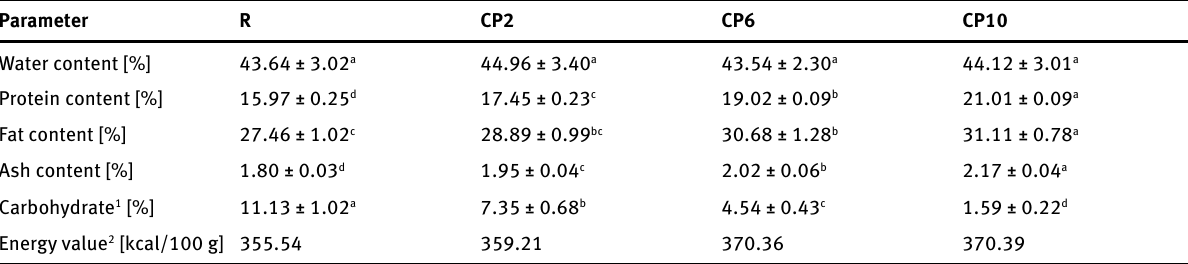
Table 1: Nutritional content and characteristics of pâtés Parameter